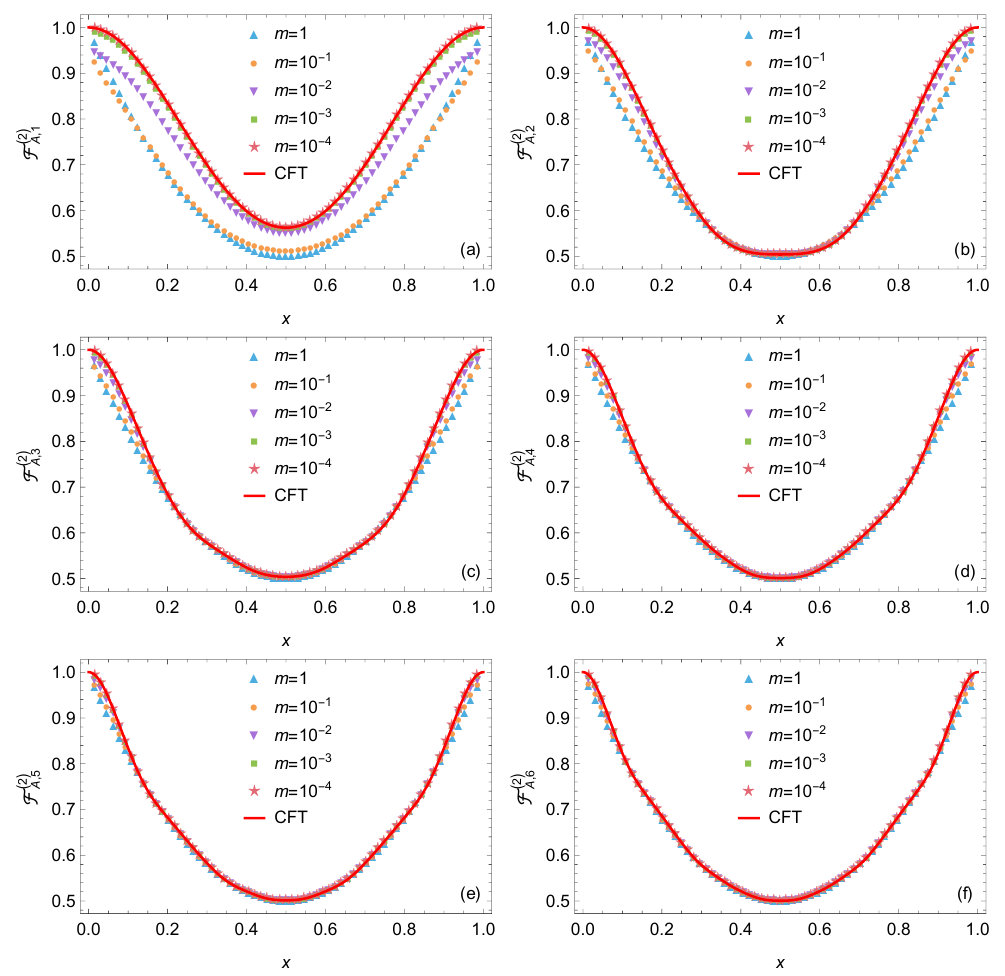
Figure 3 . The excited state single-interval Rényi entropies of the harmonic chain (symbols) and the 2D free massless bosonic theory (lines). There are perfect matches in the gapless limit m → 0 (4.27). We have set L = 64